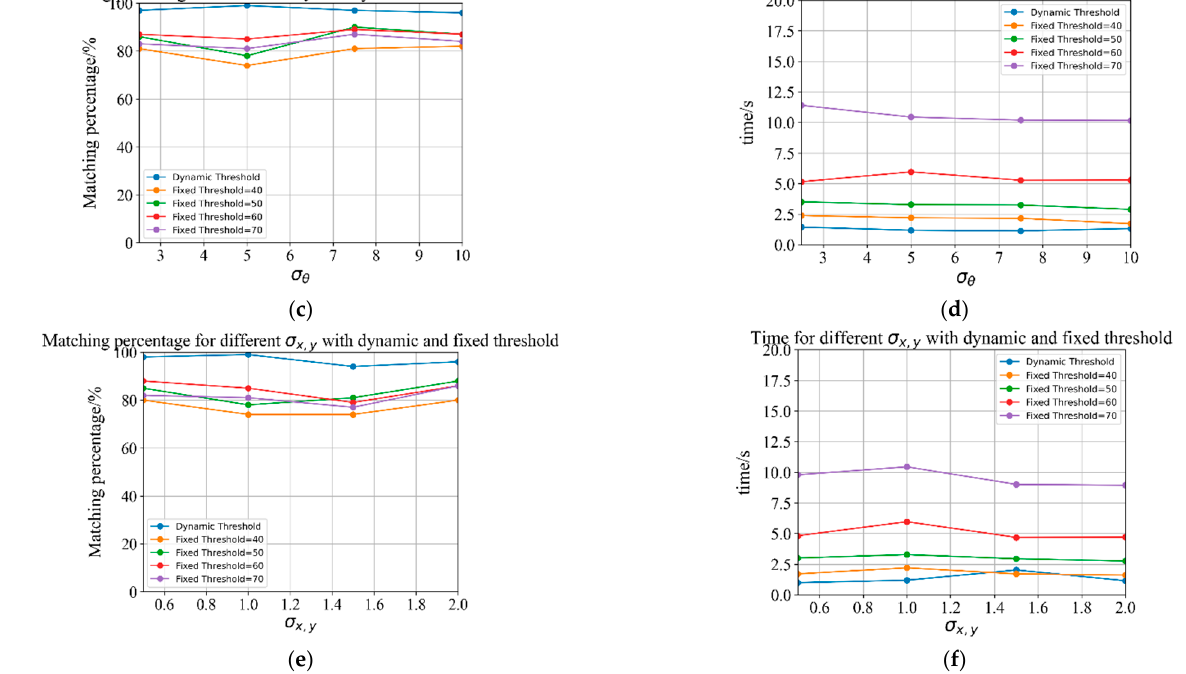
Figure 16. Matching rate and time consumed for different values of σ a , b , σ θ , and σ x , y with different thresholds.